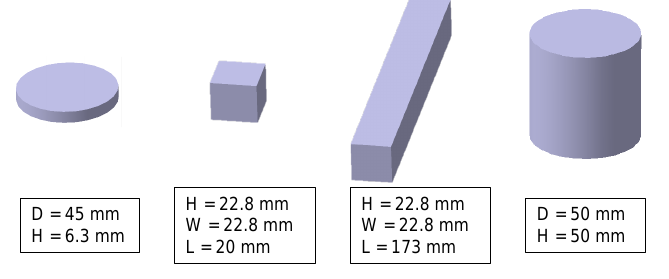
Figure 3. Specimens used in this study: A disc with 45mm diameter and 6.3mm height, two cuboids with a 22.8 × 22.8mm 2 cross-section and a length of 20mm and 175mm, respectively, and a cylinder with 50mm diameter and 50mm height.